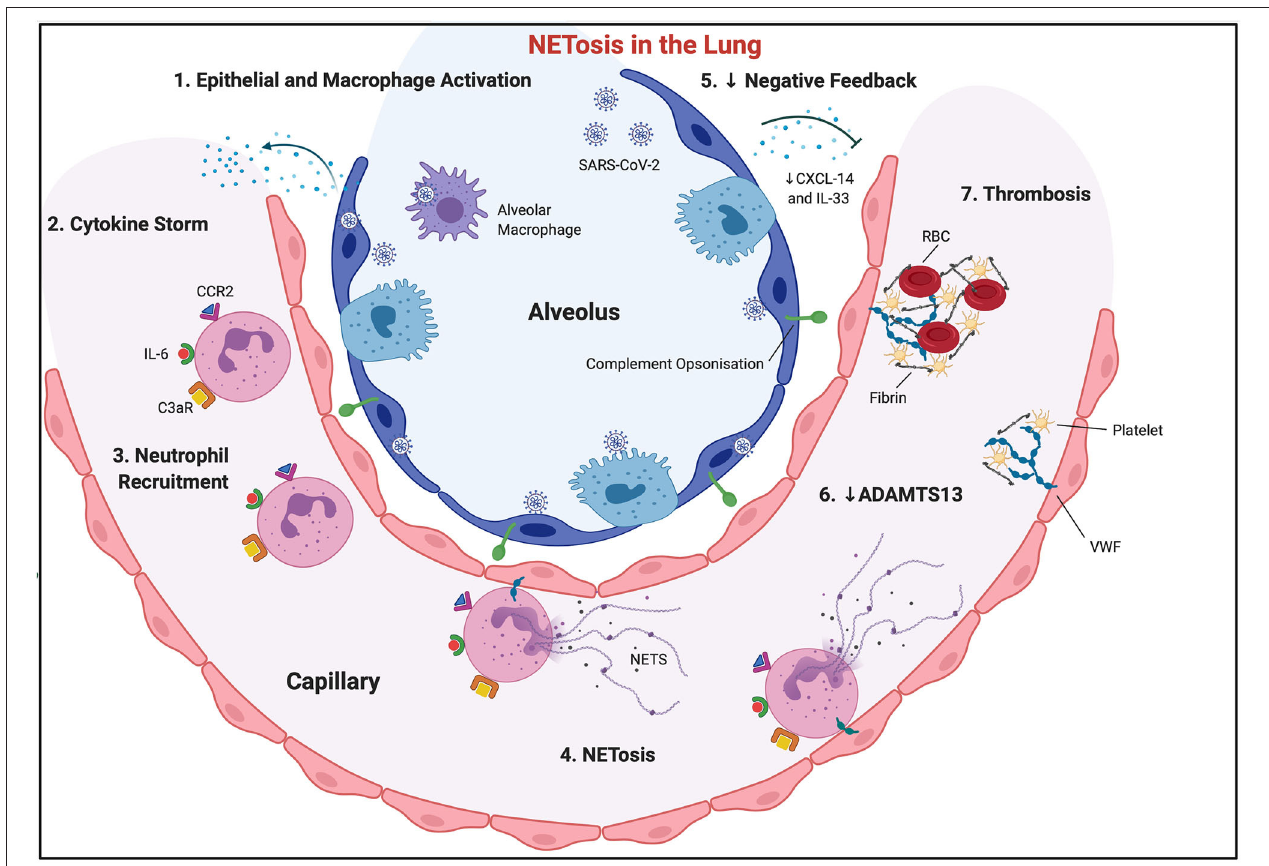
FIGURE 1 | NETosis in the lung. SARS-CoV-2 virus invades alveolar epithelial cells, activating them, along with local macrophage populations (1). This causes a surge in the production and systemic release of cytokines and chemokines (cytokine storm) ( 2), with subsequent neutrophil recruitment (3). Activated endothelial cells exocytose Von Willebrand Factor, which allows neutrophil and neutrophil extracellular trap adherence to the vascular wall. CCL2 and IL-6 encourage “NETosis” (4). Negative feedback loops may be inhibited, through reduced CXCL-14 and IL-33, allowing sustained and enhanced immune cell recruitment ( 5). Complement C3 is also released from NETs, further propagating “NETosis,” and allowing opsonisation of surrounding tissue, which will ultimately necrose. NETs downregulate ADAMTS13, allowing VWF multimer development ( 6). Subsequent fibrinogen and platelet trapping occurs, which, along with red blood cells, encourages fibrin cross-linking, and ultimate vessel